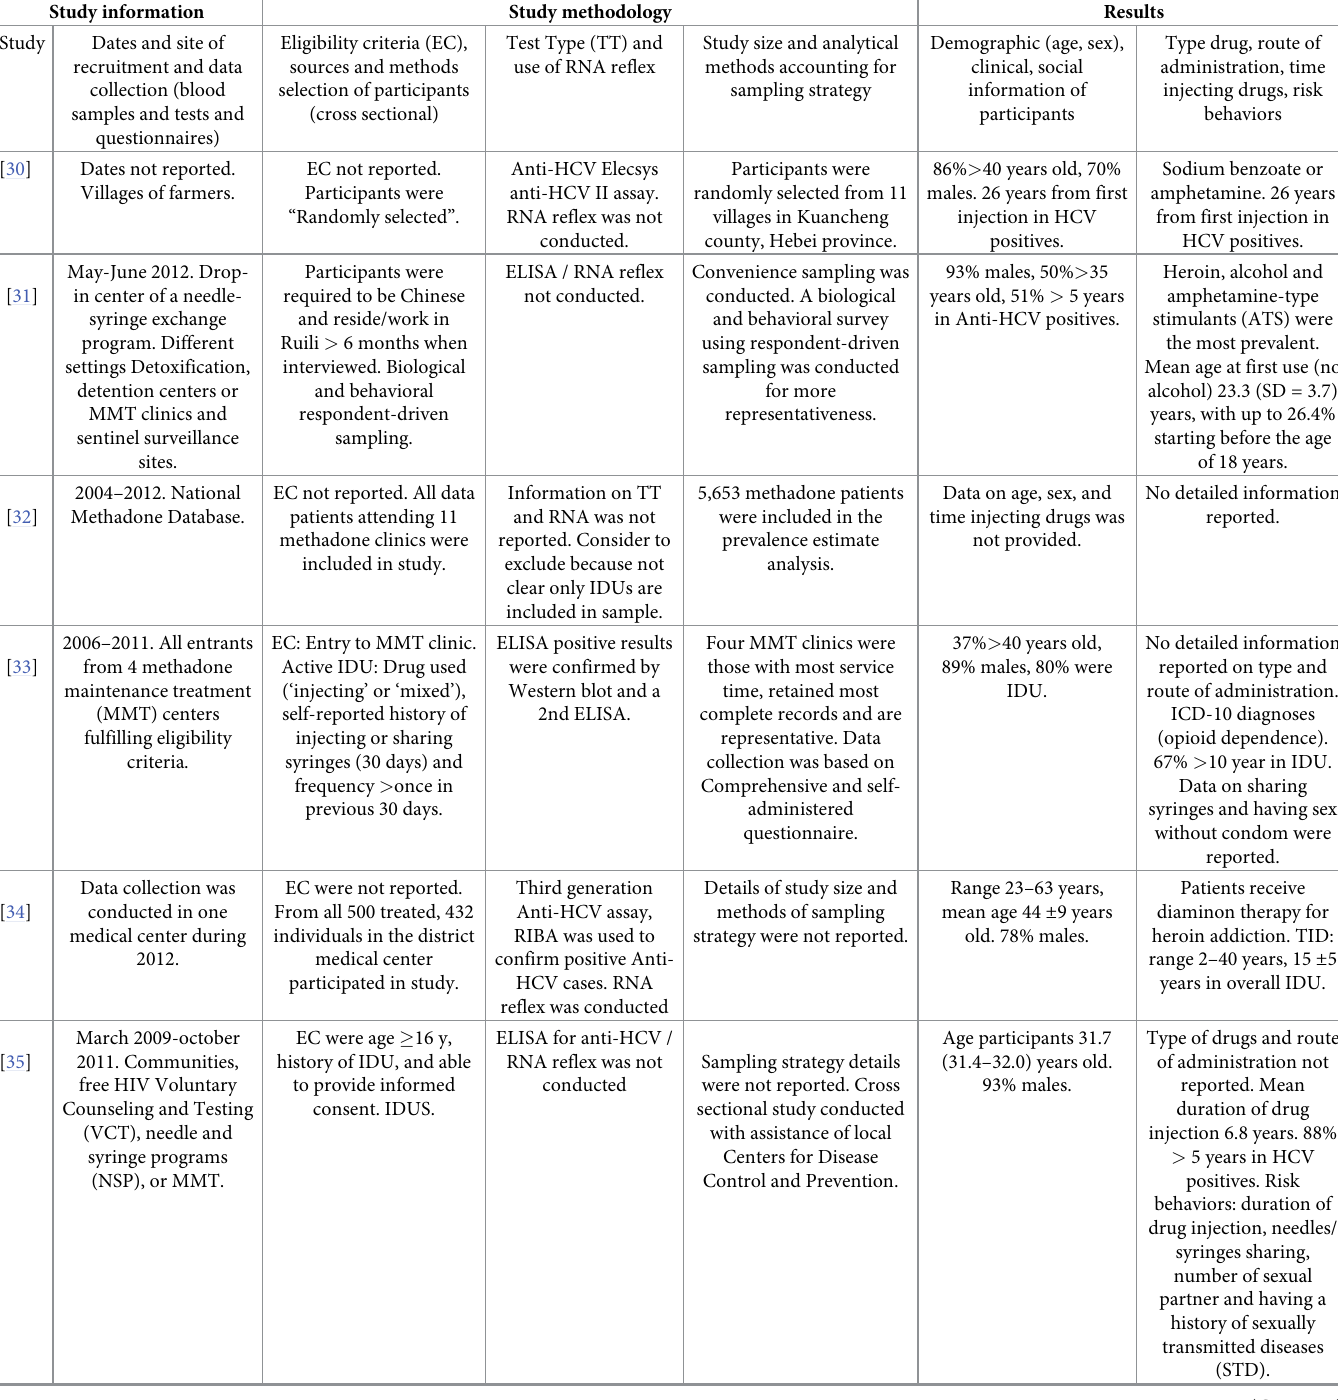
Table 1. Characteristics of studies included in the meta-analysis that report HCV prevalence data among IDUs in upper middle income